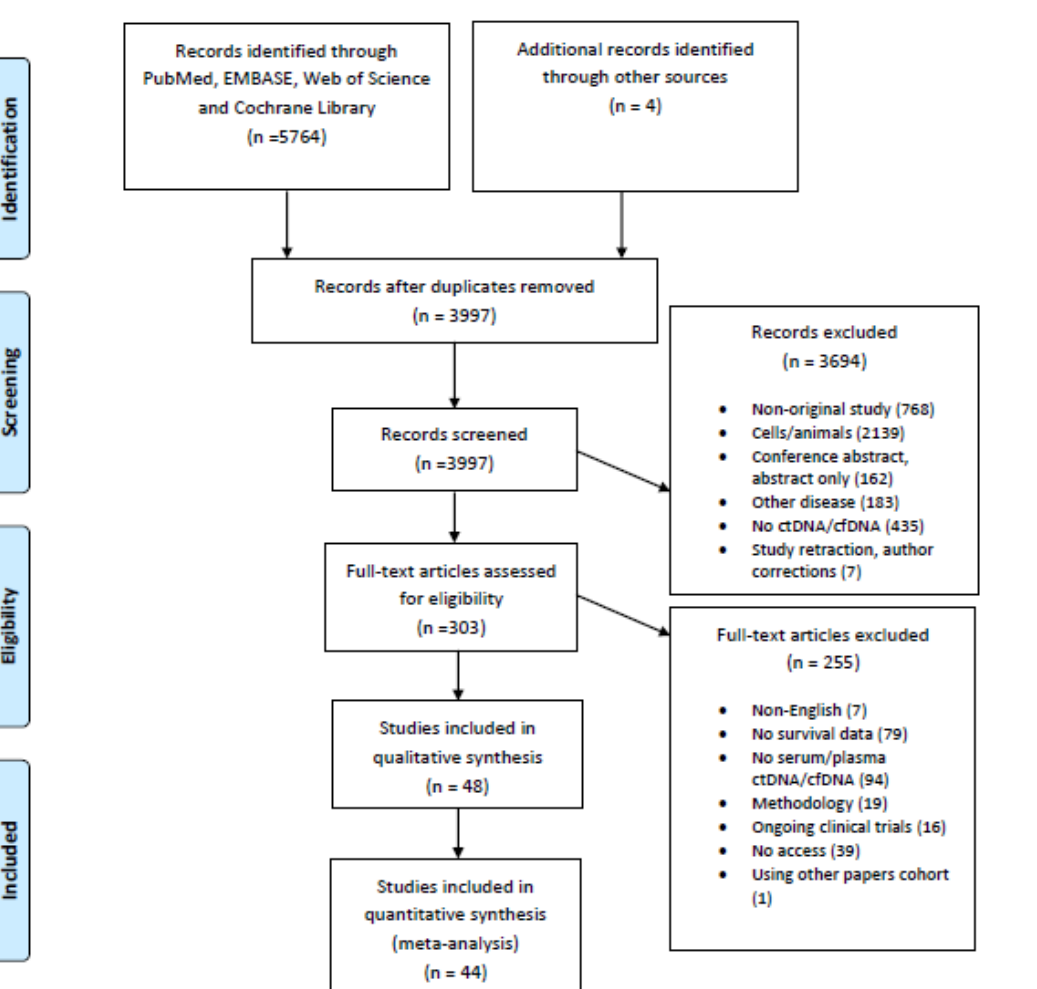
Figure 1. Flow chart of the study selection.